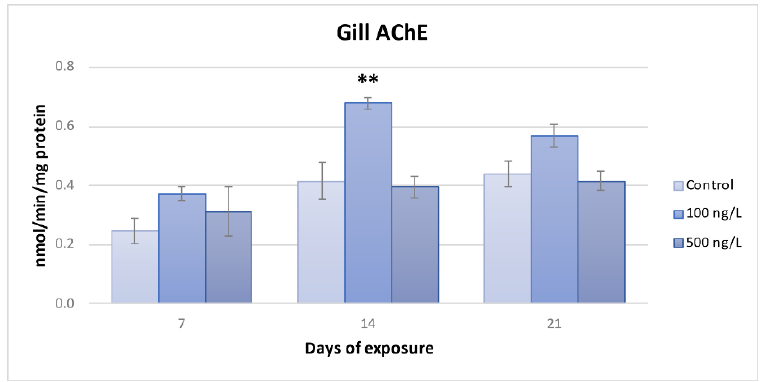
Figure 5. Acetylcholinesterase activity values in the gills of Ruditapes philippinarum after exposure to 100 ng/L and 500 ng/L of HHCB for 7, 14 and 21 days. The results are expressed as nmol/min/mg of proteins and are reported as means ± standard error; n = 6. Asterisks indicate significant differences compared to controls at the same time of exposure: ** p < 0.01.